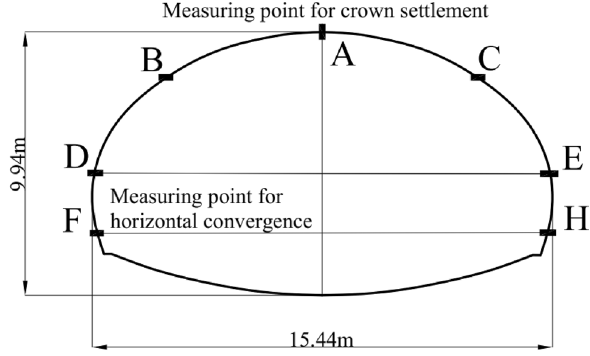
Figure 5. Schematic diagram of monitoring point layout.